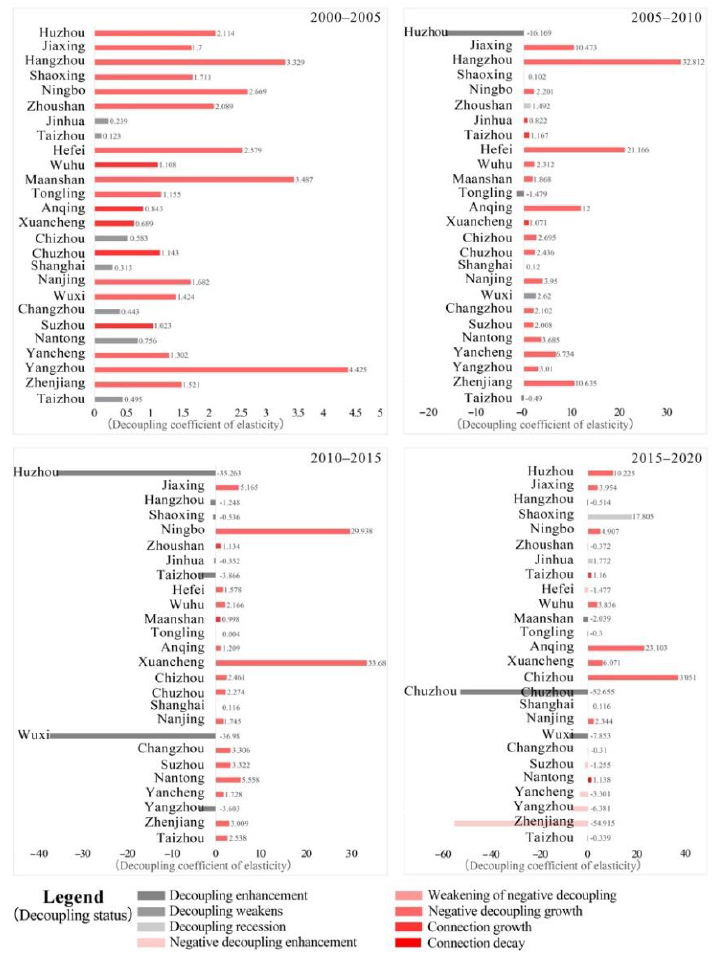
Figure 6. Decoupling of CEEC and industrial output value of prefecture-level cities in the YRD region from 2000 to 2020.